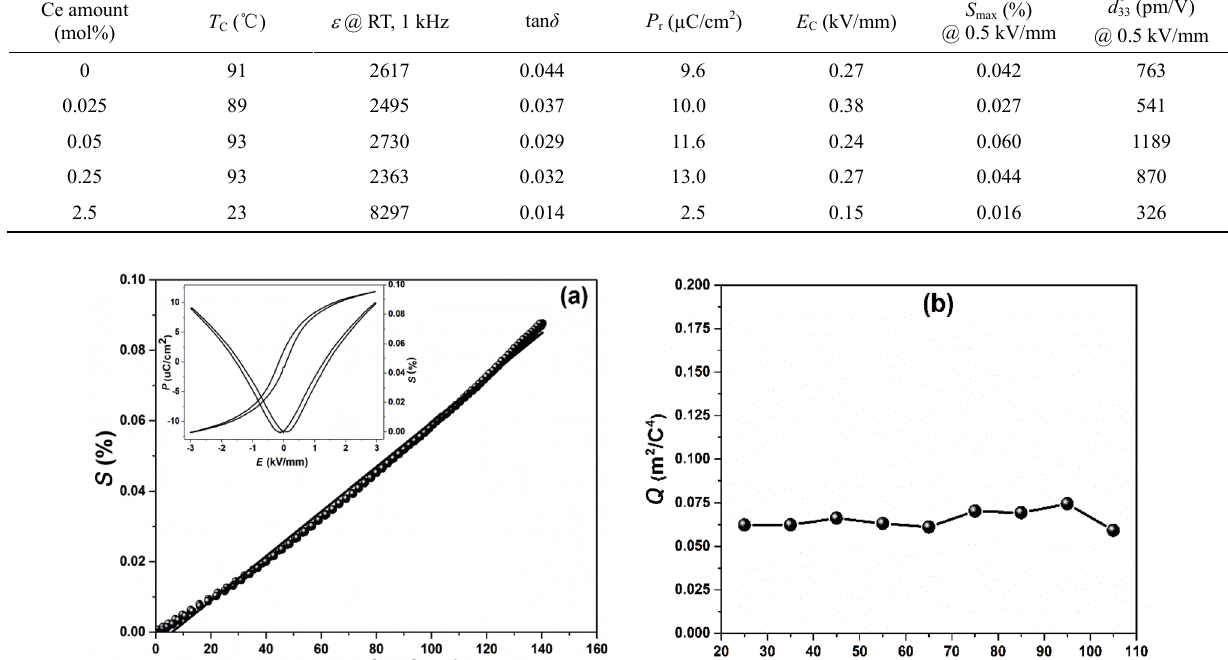
Fig. 8 (a) The plot of strain vs. square polarization and (b) the temperature dependence of bipolar electrostrictive coefficient Q 33 for BCCe 2.5 ZT